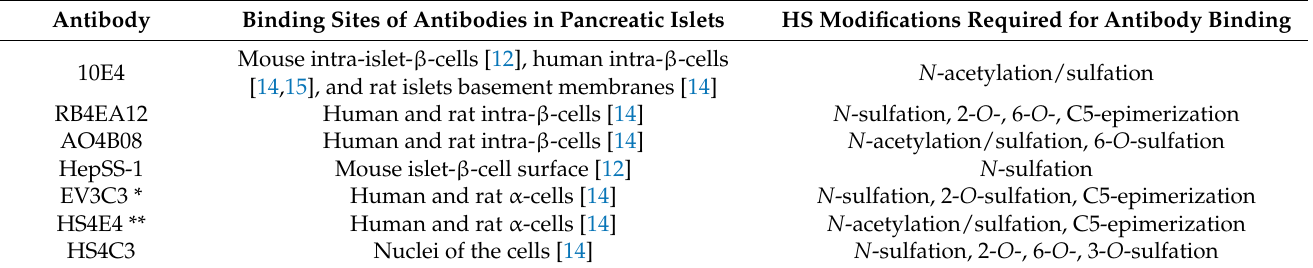
Table 2. GAG domain-specific antibodies, binding loci in pancreatic islets, and modifications for enhancing their